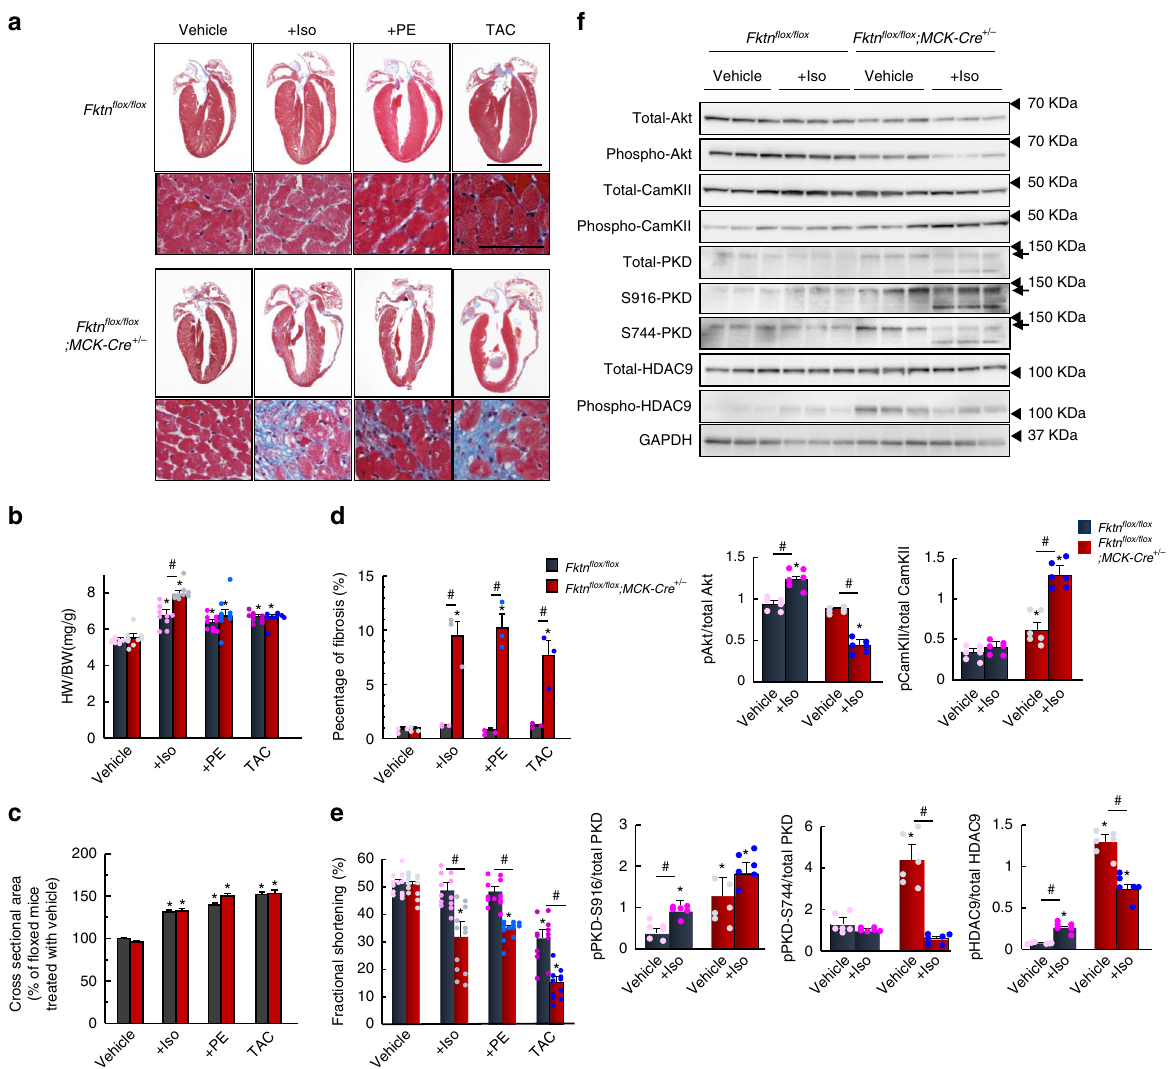
Fig. 3 Hypertrophic responses of 10-week-old MCK- Fktn -cKO ( Fktn fl ox/ fl ox ; MCK-Cre + / − ) hearts. a Cardiac morphology and histology following isoproterenol (Iso) or phenylephrine (PE) administration or thoracic aortic constriction (TAC) for 2 weeks in control ( fl oxed) and MCK- Fktn -cKO mice. Scale bar, 5 mm (top) and 50 μ m (bottom). b Heart weight-to-body weight ratios (HW/BW) ( n = 9 mice per group). Cross-sectional areas (vehicle, n = 252 cells; + Iso, n = 283 cells; + PE, n = 249 cells; TAC, n = 264 cells from 3 control ( fl oxed) mice. Vehicle, n = 315 cells; + Iso, n = 250 cells; + PE, n = 229 cells; TAC, n = 274 cells from 3 MCK- Fktn -cKO mice) ( c ) and fi brosis percentages ( n = 3 mice per group) ( d ) from paraf fi n sections of left ventricles. e Fractional shortening in hearts of treated and untreated control ( n = 12 mice per group). * P < 0.05 vs. vehicle-treated fl oxed mice; # P < 0.05 between indicated groups based on Tukey – Kramer tests. f Representative immunoblots for total and phosphorylated Akt, CamKII, PKD, and HDAC9 levels in control and MCK- Fktn -cKO mice after Iso (or vehicle) treatment. GAPDH was used for a loading control ( n = 6 per group). * P < 0.05 vs. vehicle-treated fl oxed mice; # P < 0.05 between indicated groups based on Tukey – Kramer